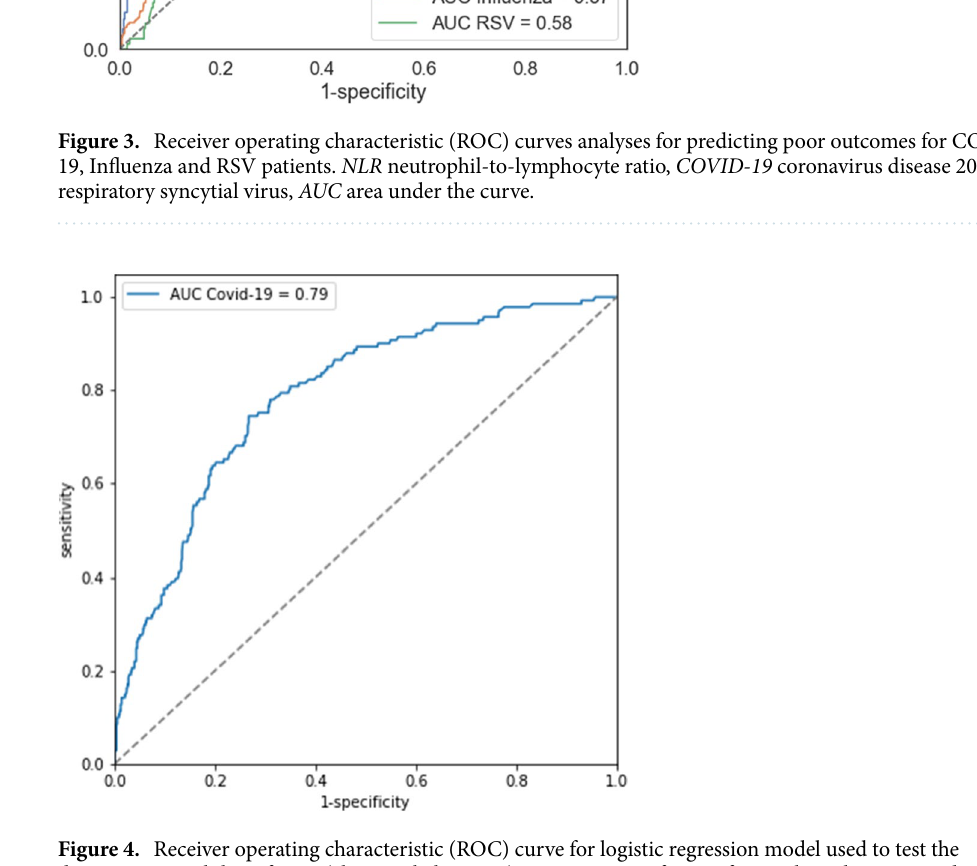
Figure 4. Receiver operating characteristic (ROC) curve for logistic regression model used to test the discrimination ability of NLR (above or below 6.82) as a prognostic factor of poor clinical outcome adjusted to age, sex and Charlson comorbidity index among COVID-19 patients. NLR neutrophil-to-lymphocyte ratio, COVID-19 coronavirus disease 2019, AUC area under the curve, CCI Charlson comorbidity